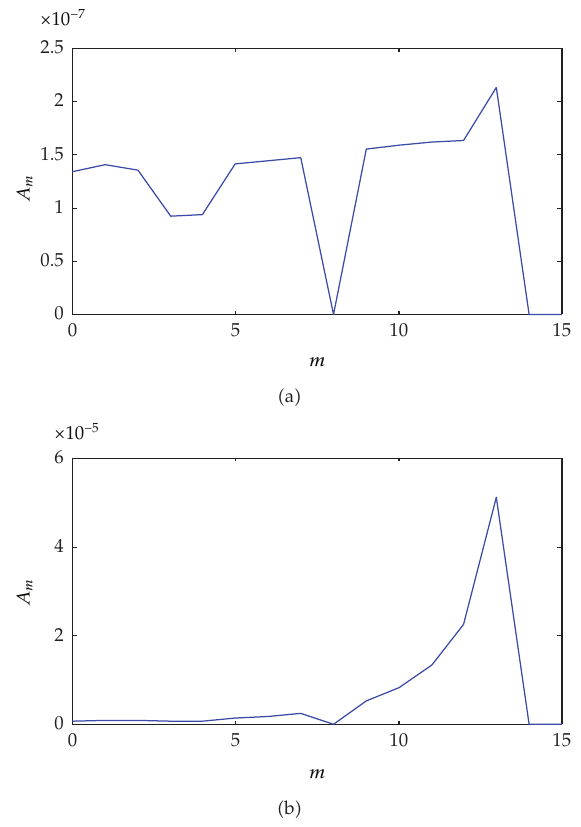
Figure 1: The dependencies of the amplitude level A m on the mode order reflecting the influence of cubic nonlinearity on the self-organization process evolution, (cid:3) a (cid:4) corresponds to t (cid:7) 5, (cid:3) b (cid:4) is related to t (cid:7) 50, thus the obtained curves represent an asymptotic estimation of amplitude